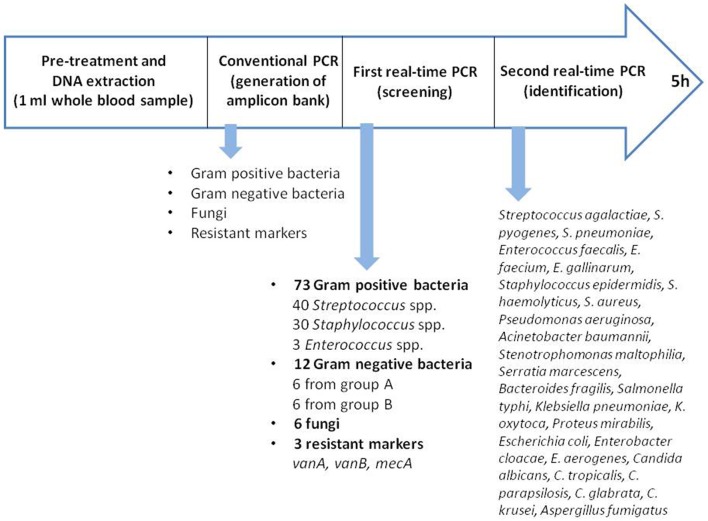
Process of Magicplex™ sepsis.